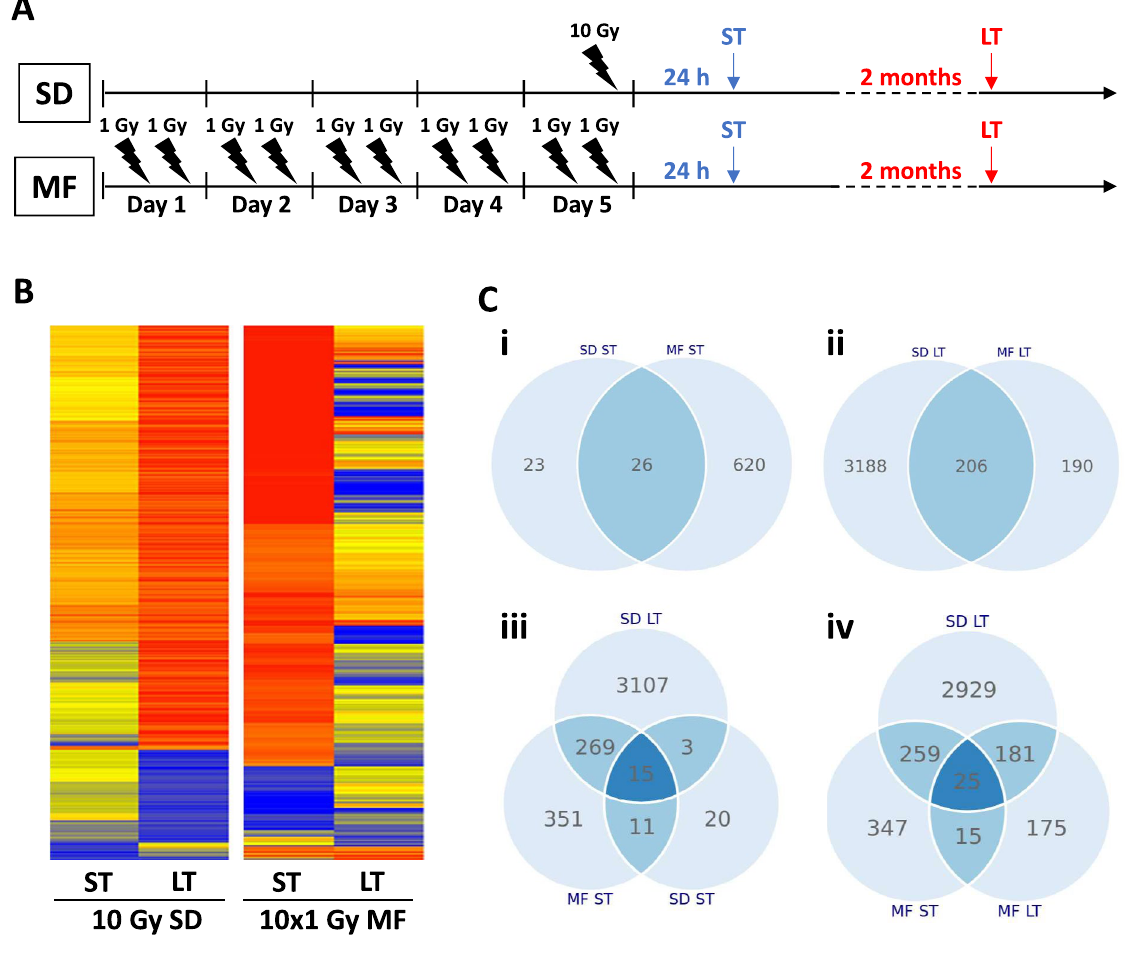
Figure 1. Gene expression after irradiation is fractionation- and time-dependent. ( A ) Treatment schedule for single dose (SD) and multifractionated (MF) irradiation. MF irradiation was performed with 2 fractions of 1 Gy per day to a total dose of 10 Gy. ( B ). Heat map of gene expression which was analyzed at 24 h (short term, ST) or 2 months (long term, LT) after the final irradiation dose. Relative gene expression was normalized to the unirradiated control. ( C ) Venn diagrams showing the number of overlapping or distinct significantly altered genes (fold change ≤ 0.66 or fold change ≥ 1.5, P < 0.05) under the different treatment conditions compared to the unirradiated